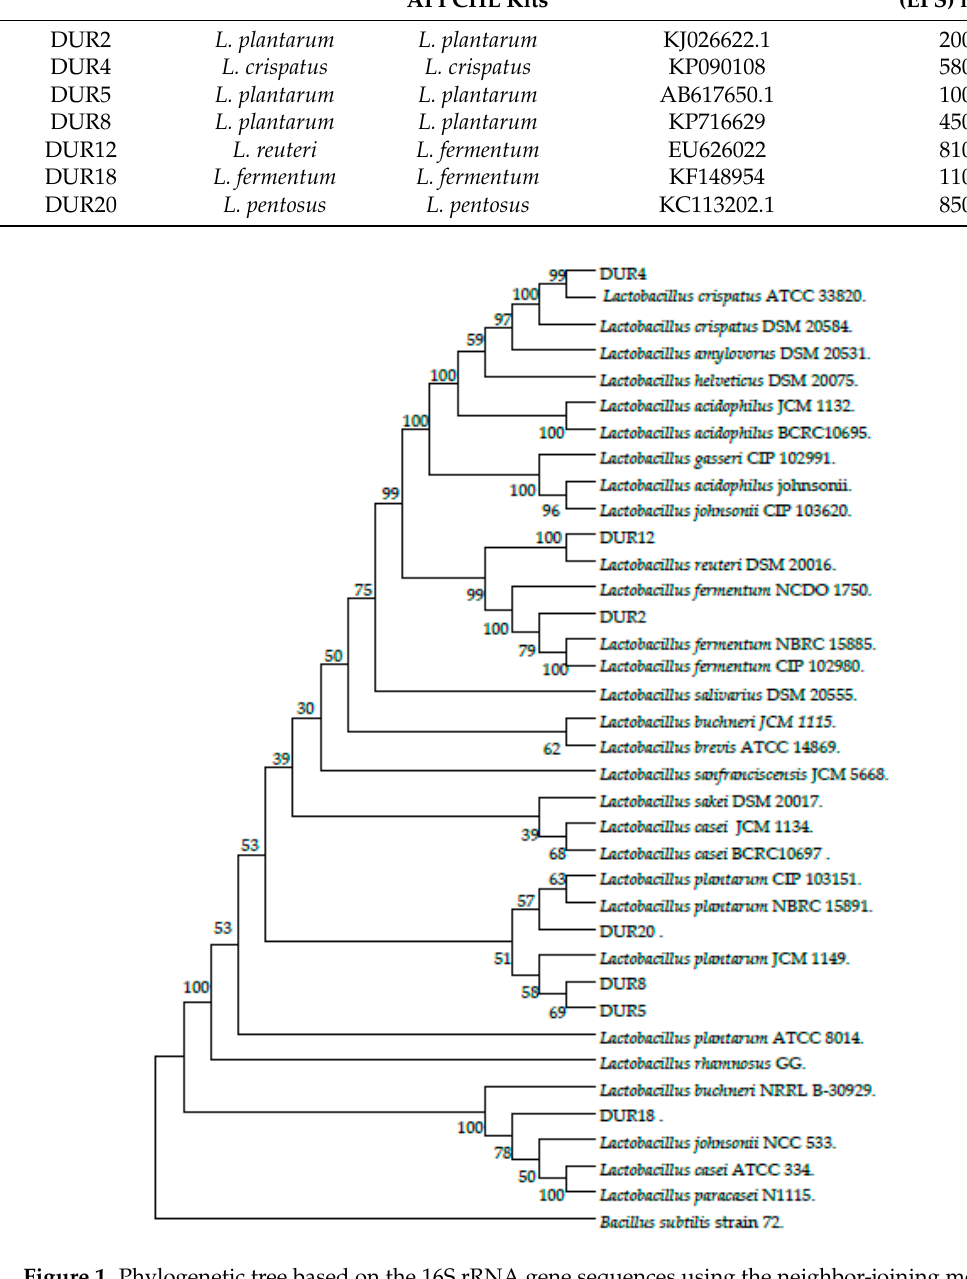
Figure 1. Phylogenetic tree based on the 16S rRNA gene sequences using the neighbor-joining method. The seven isolated strains are (DUR2, 4, 5, 8, 12, 18, and 20). Bacillus subtilis was used as an out group nucleotide. Bootstrap values above 50% are indicated at the nodes of the tree. The scale bar represents 0.02-nucleotide substitutes per position.